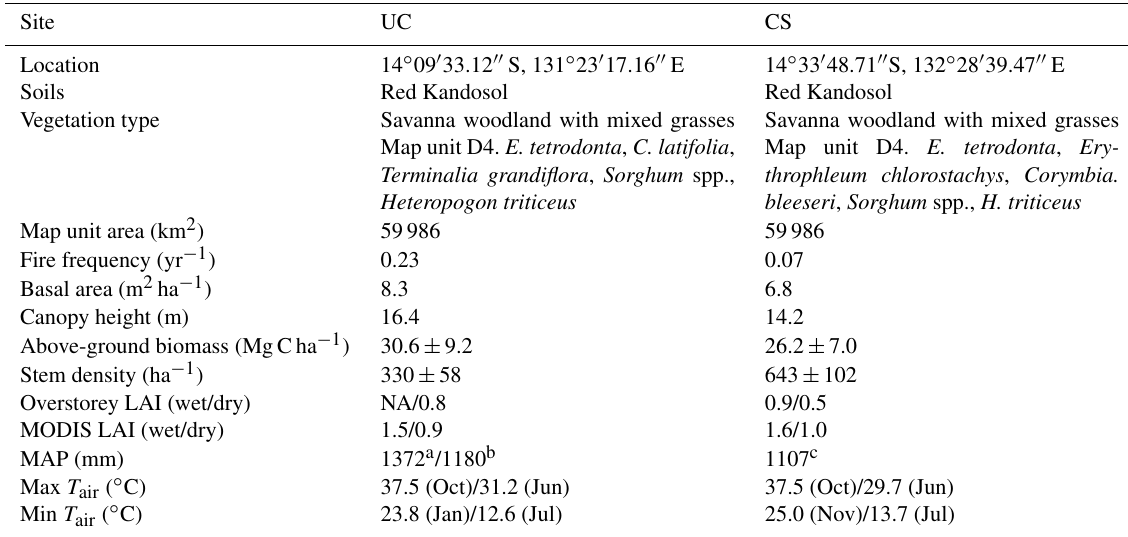
Table 1. Site characteristics for the uncleared savanna (UC) and cleared (CS) sites. Site soil orders are given as in Isbell (2002) with savanna vegetation classified using Fox et al. (2001). Fire frequency was estimated from fire mapping taken from the North Australian Fire Information system (NAFI, www.firenorth.org.au) for 2000–2012. The fire frequency estimate for the CS site excluded the debris fires in August 2012. Basal area and stem density is provided for all woody stems >2cm DBH at both sites. Mean site LAI for the UC is taken from Hutley et al. (2011) and for the CS site, was estimated from canopy hemispherical photos, see text for details.